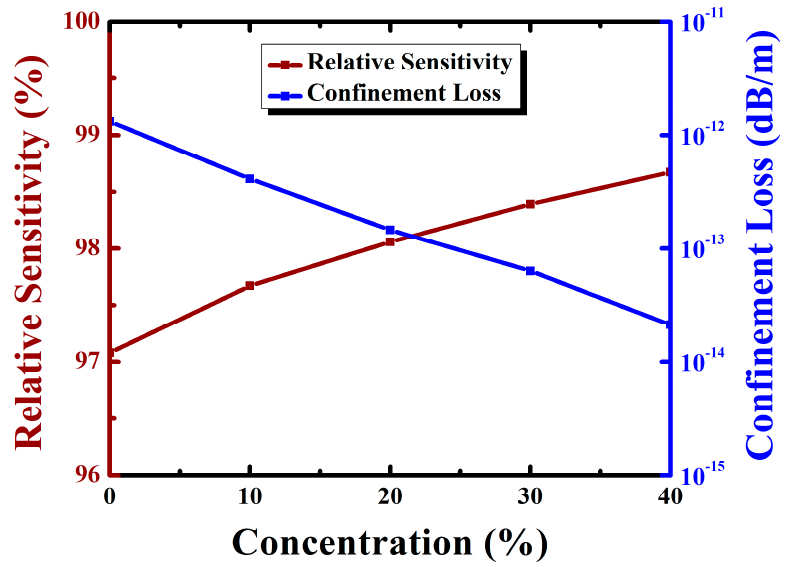
Figure 9. Variation of relative sensitivity and confinement loss with respect to concentrations of sulfuric acid (0%, 10%, 20%, 30%, and 40%).